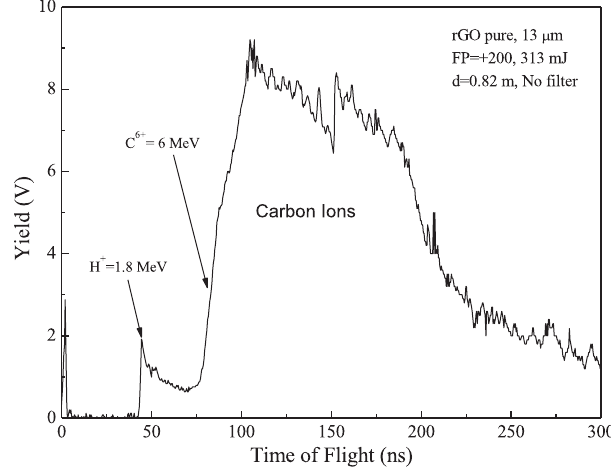
FIG. 2. SiC-TOF spectrum obtained irradiating a graphene oxide foil, 13 μ m thick, by 313 mJ pulse using a TOF distance of 0.82